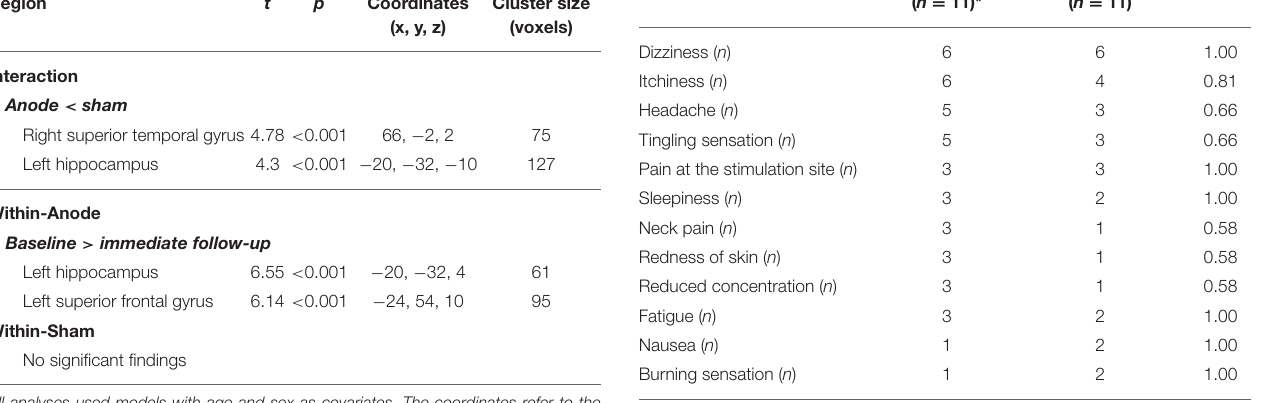
TABLE 3 | Information on the significant clusters for both the interaction contrast and the within-group contrast. Region